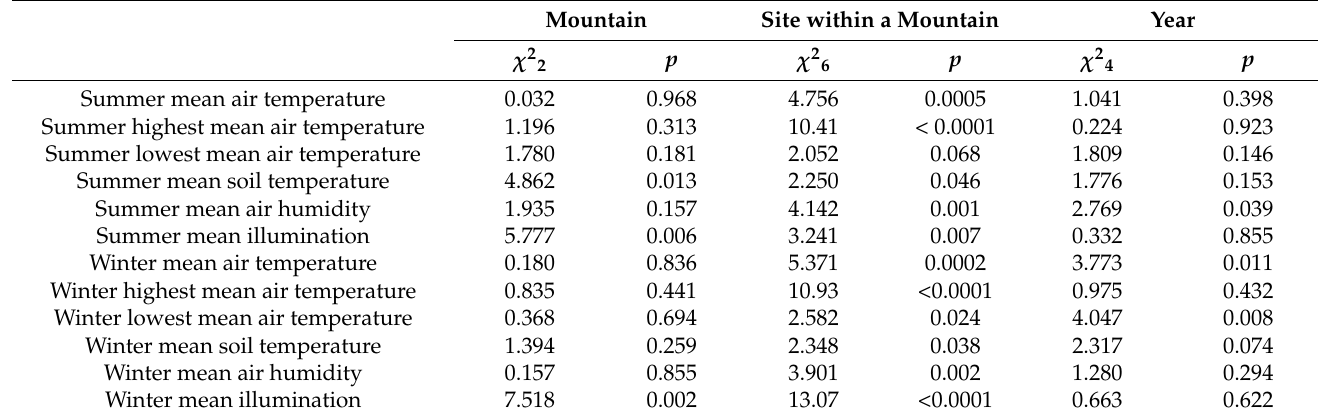
Table A3. Generalized linear models (GLMs) of environmental factors.